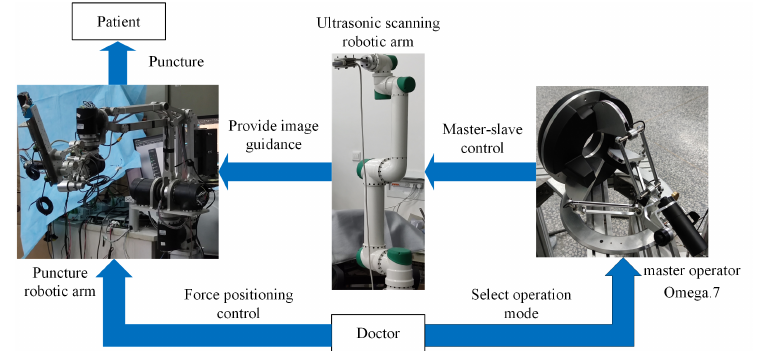
Figure 1. Dual-arm puncture robot system